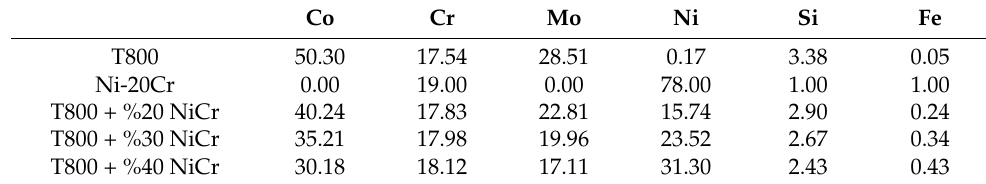
Figure 1. Laser DED AM process schematic. Table 1. Chemical composition of T800 and NiCr alloy powders and their mixtures by weight. Table 2. Fabrication parameters of T800 and NiCr mixtures by weight.